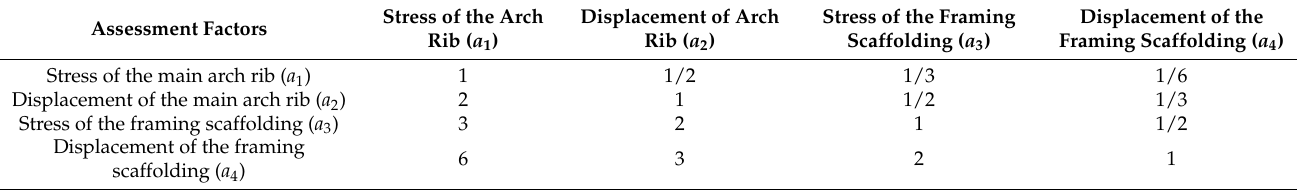
Table 5. Weight index of comprehensive evaluation during demolition